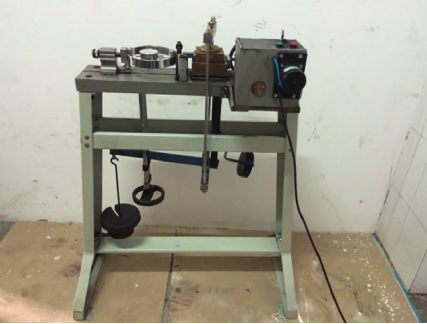
Figure 11: ZJ-type strain controlled direct shear apparatus.